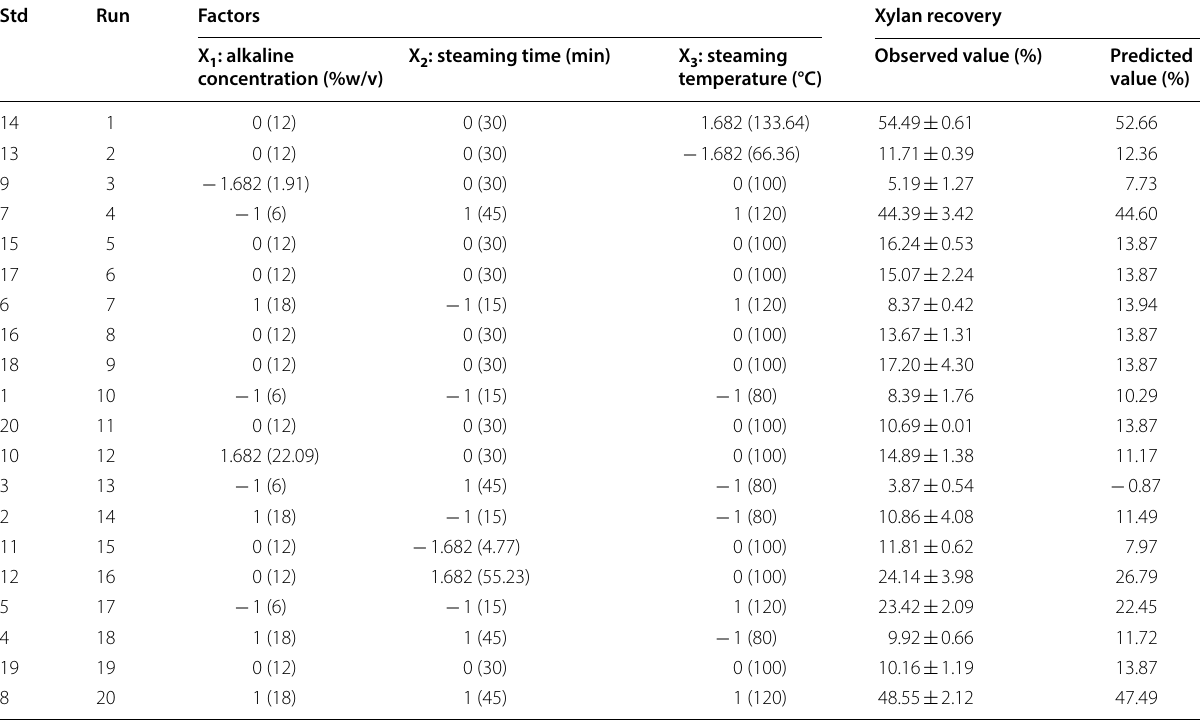
Table 1 The variable factors and predicted and observed xylan recovery Std